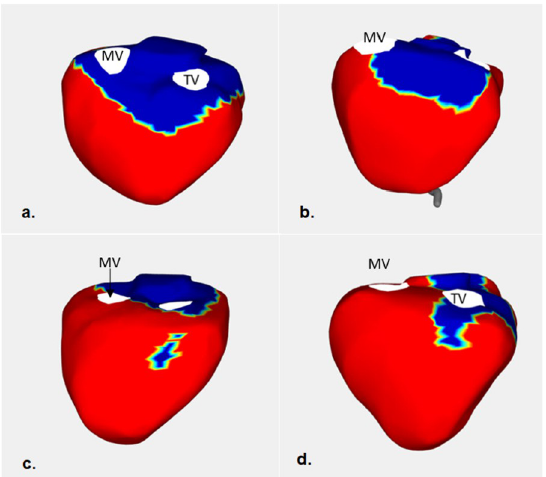
Fig 3. Examples of terminal ventricular activation in four M-carriers. The figure presents the area activated during the last 20 msec of the total ventricular epicardial activation (noted with blue colour) in four M-carriers. Note that the terminal ventricular activation could occur at RVOT and LV base, as in controls (a, b); could additionally involve other parts of the RV, like the inferior wall (c); the terminal ventricular activation could only involve parts of the RV, not involving the LV (d). Same abbreviations as in Fig